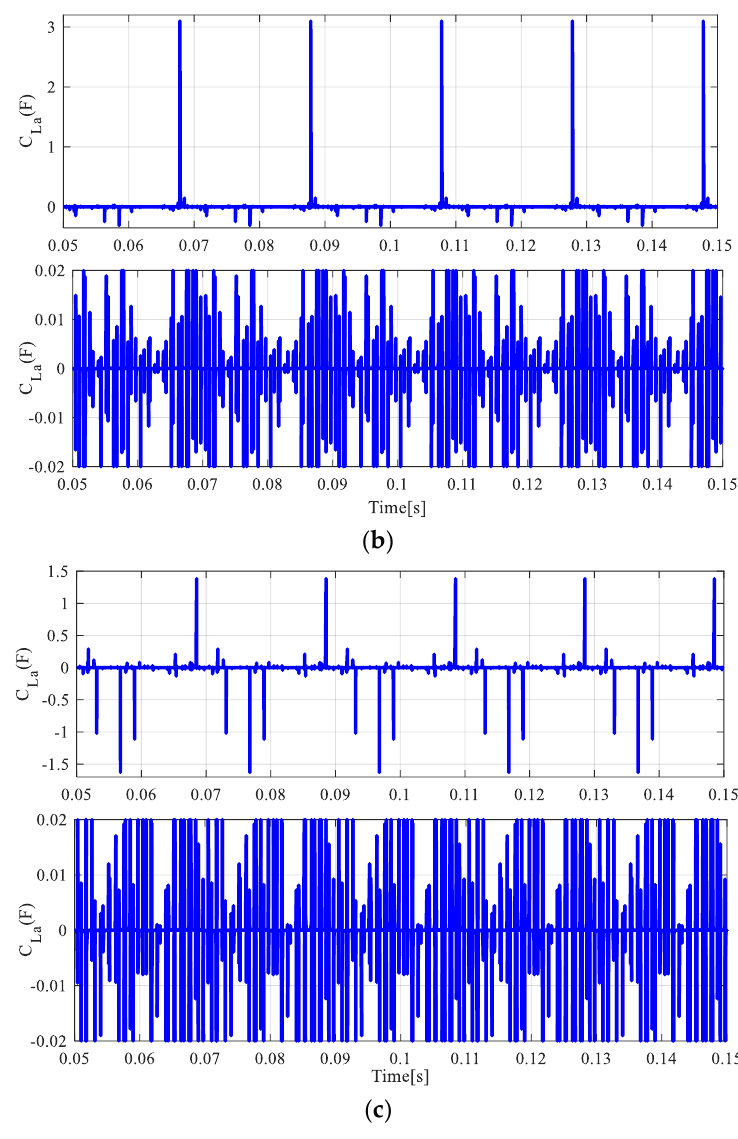
Figure 9. Equivalent capacitors for the lower arm of phase “a” : ( a ) first controller, ( b ) second controller, and ( c ) third controller.